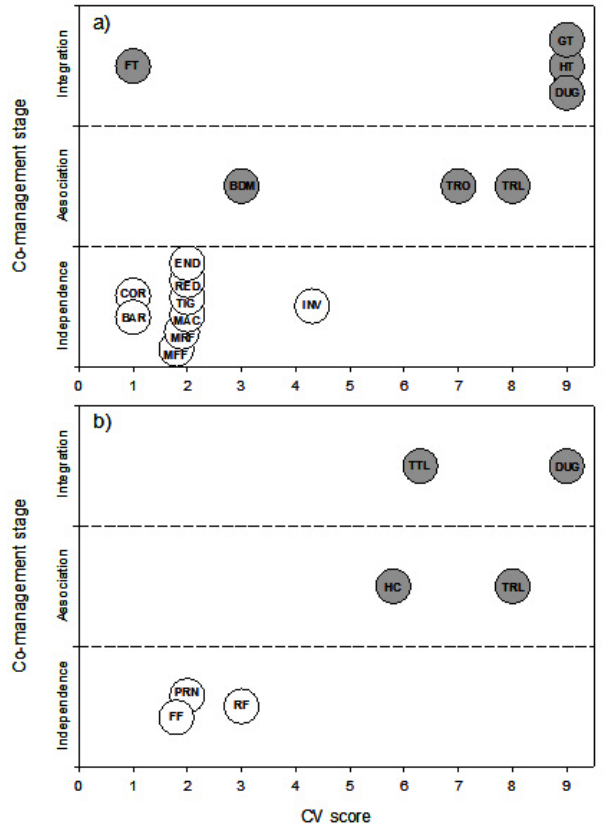
Fig. 5 . The relationship between cultural domain (CV) scores for a) fishery species or groups and b) fisheries, the stage of comanagement reached in 2009 and the application of traditional ecological knowledge (TEK). Grey symbols are species or fisheries where TEK was applied, and white symbols are those where TEK was not